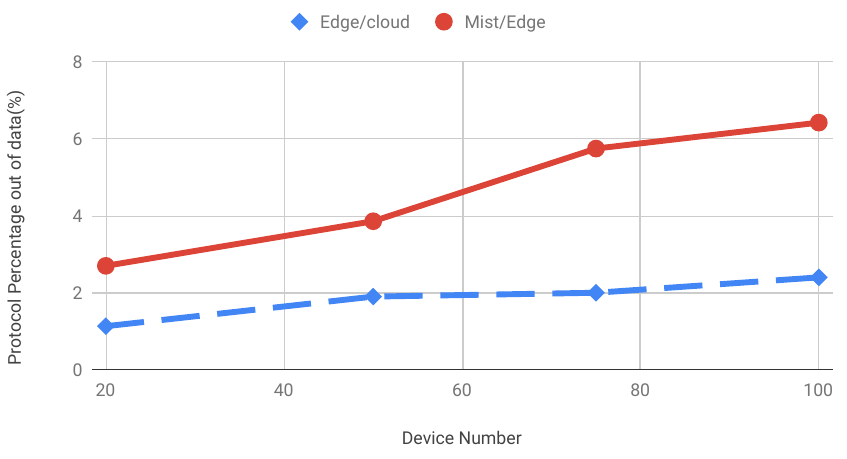
Figure 16. Protocol percentage out of data messages overall sent in the network by devices. We measured the total amount of bytes sent by devices active in the network and the protocol byte